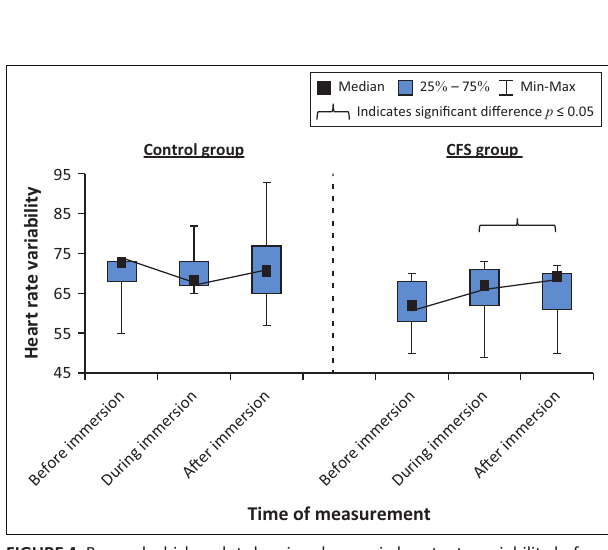
FIGURE 2: Box and whisker plot showing changes in diastolic blood pressure before, during and after immersion of the control and chronic fatigue syndrome groups.